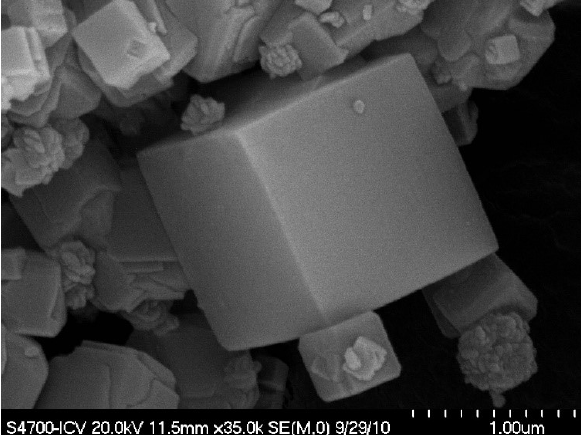
Figure 4: SEM image of LTA zeolite powders showing a large cubic crystal obtained by the hydrothermal method.